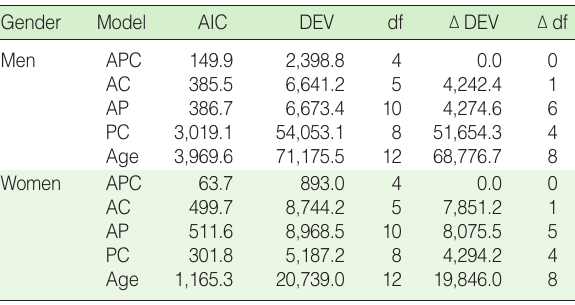
APC, age-period-cohort model; AIC, Akaike information criteria; DEV, devi- ance; df, degree of freedom; AC, age-cohort model; AP, age-period mod- el; PC, period-cohort